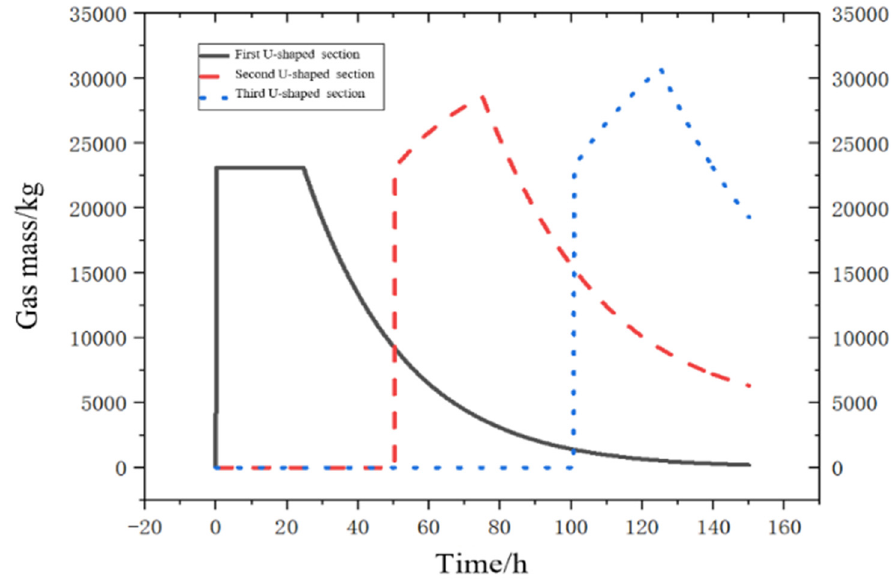
Figure 15. Variation in the mass change of a gas section in the multi-pipe simulation example.